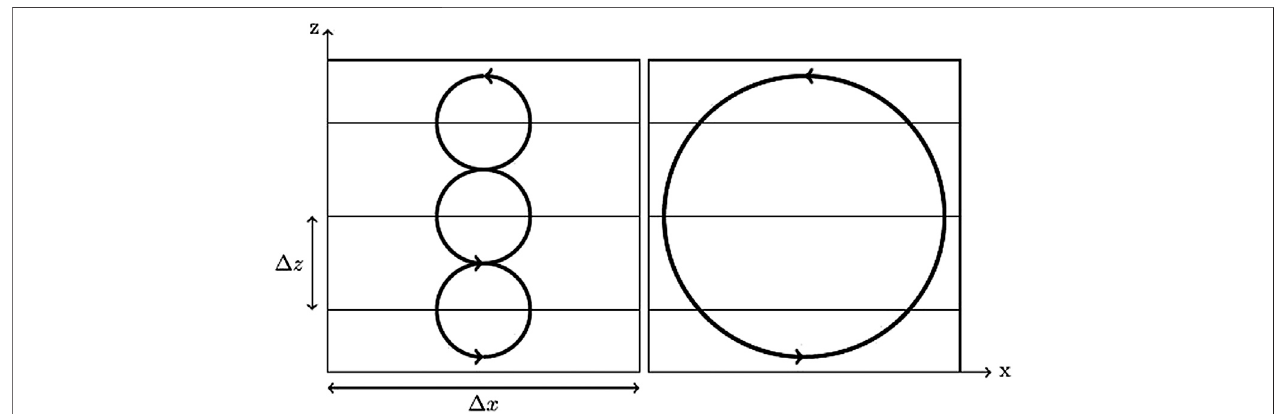
FIGURE 3 | Schematic turbulent eddy in the gray zone of turbulence when the mixing length depends on Δ z (left) or not (right) .